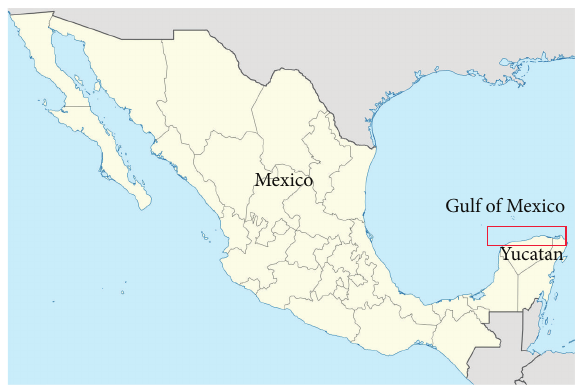
Figure 1: Eroded area at the northern coast of Yucatan,